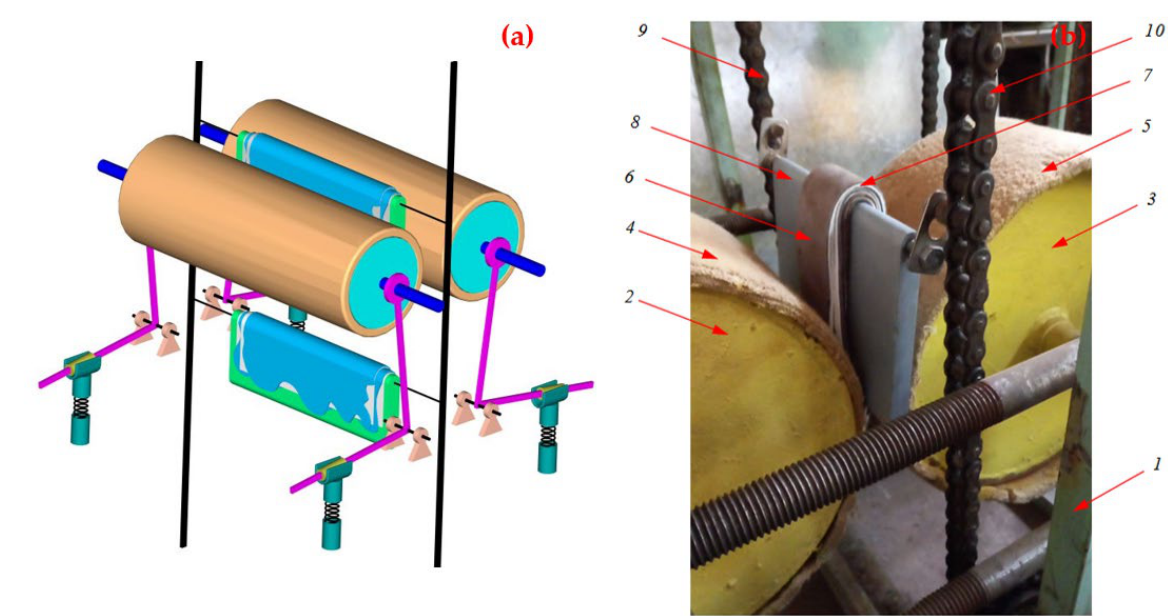
Figure 11. Schematic 3D view of a roller stand ( a ) and method for multi-layer dewatering of wet semi-finished leather products ( b ).1—stand frame, 2, 3—extrusion rollers, 4, 5—roller covers, 6—outer (first) layer of semi-finished product, 7—moisture-wicking fabric, 8—base plate, 9, 10— transport chains.